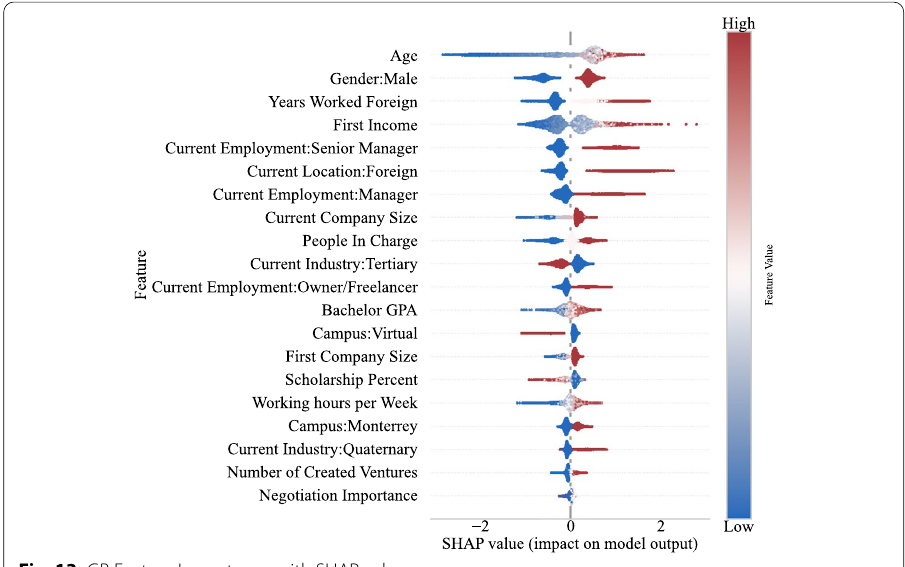
Fig. 13 GB Feature Importance with SHAP